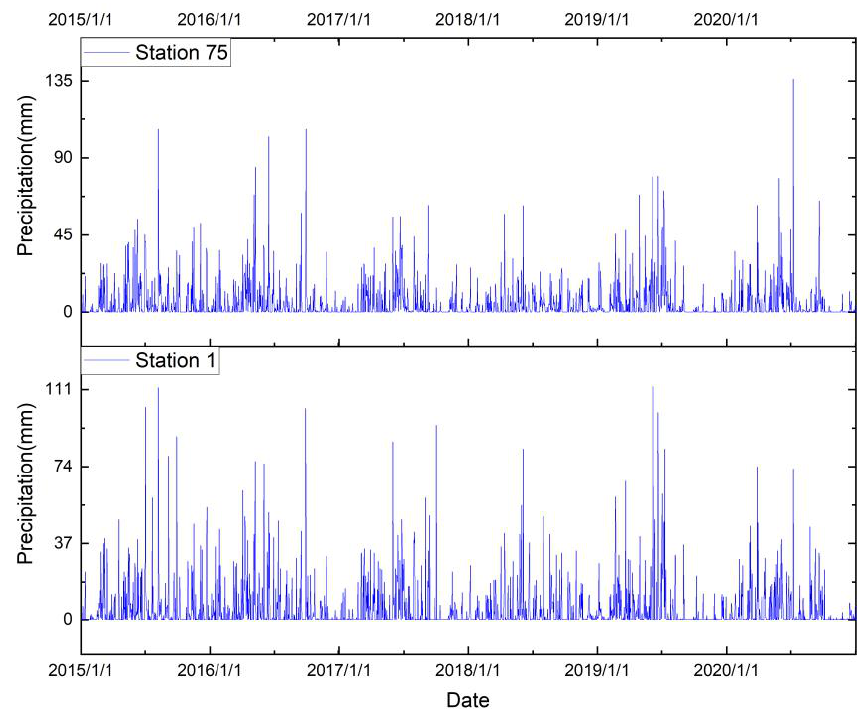
Figure 5. Daily precipitation data series at stations 1 and 75 from 1 January 2015 – 31 December 2020.